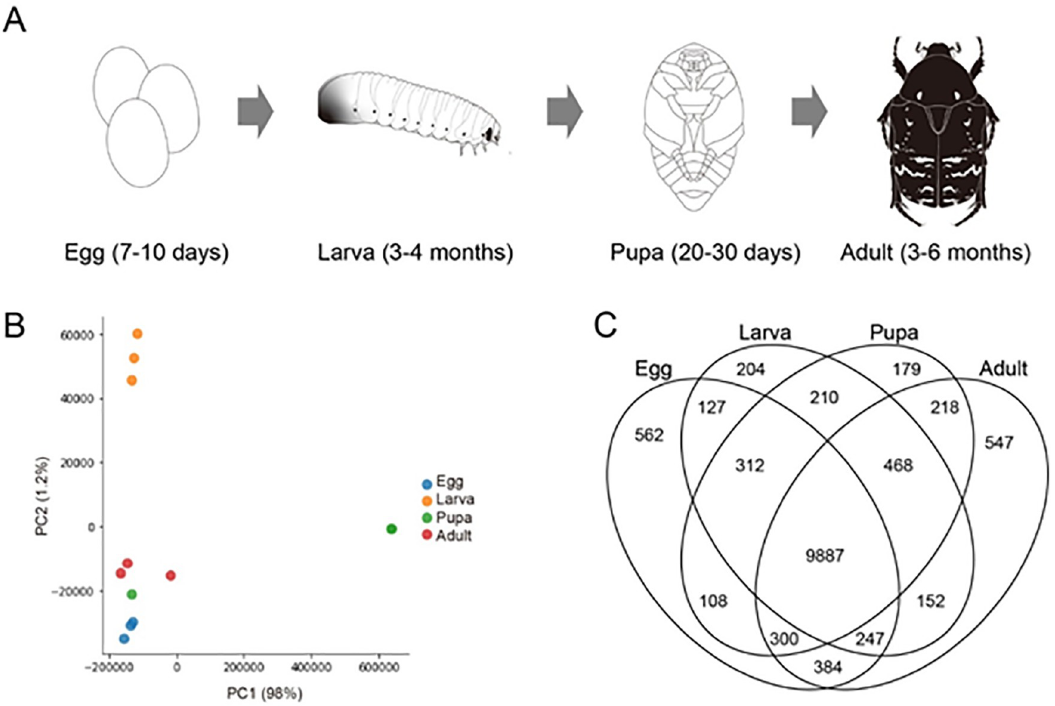
Fig 1. Quality assessment of P. b. seulensis RNA-sequencing (RNA-seq) data. ( a ) 4 development stages of P. b. seulensis for RNA- seq. ( b ) Grouping of samples via principal component analysis based on the P. b. seulensis transcriptome expression abundance. ( c ) Venn diagram shows the unique and shared unigenes during P. b. seulensis